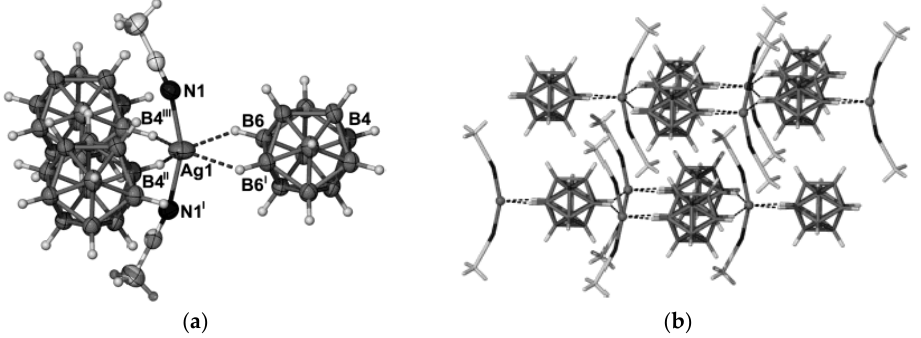
Figure 84. The coordination sphere of the Ag atom ( a ) and crystal packing ( b ) in the structure of {(MeCN) 2 Ag[CB 11 H 12 ]} n . Reprinted with permission from reference [105]. Copyright © (2004) American Chemical Society.